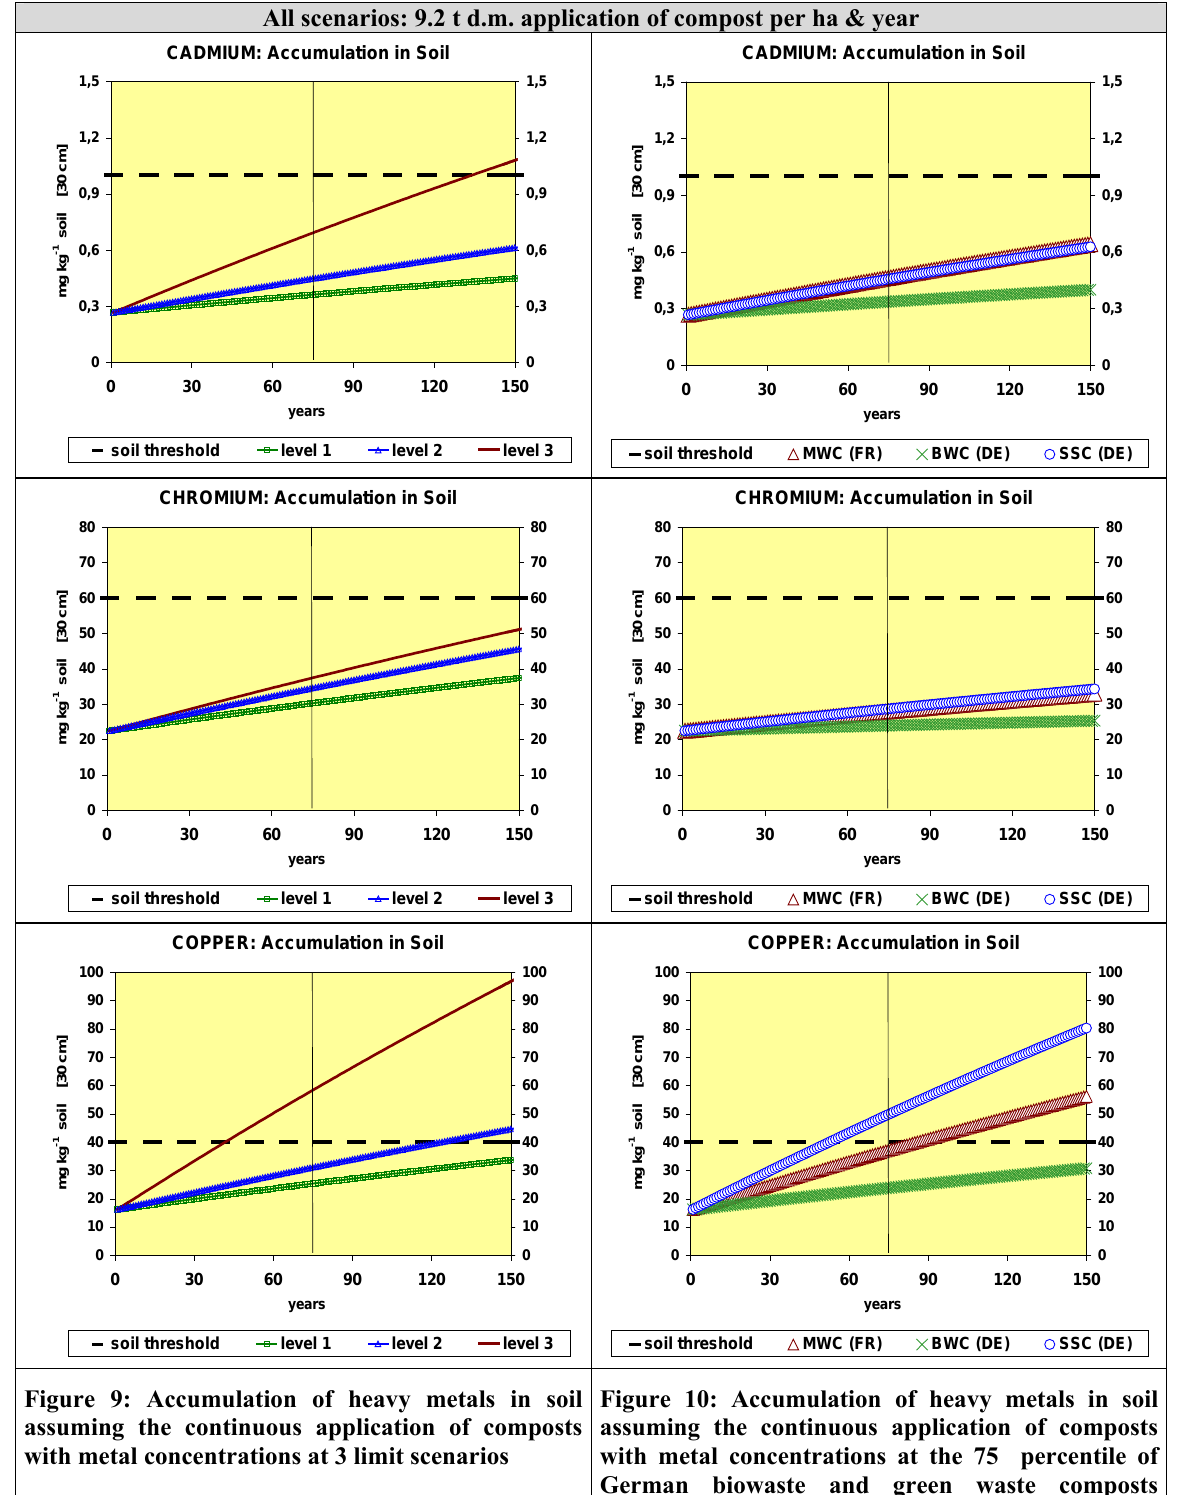
Figure 9: Accumulation of heavy metals in soil assuming the continuous application of composts with metal concentrations at 3 limit scenarios